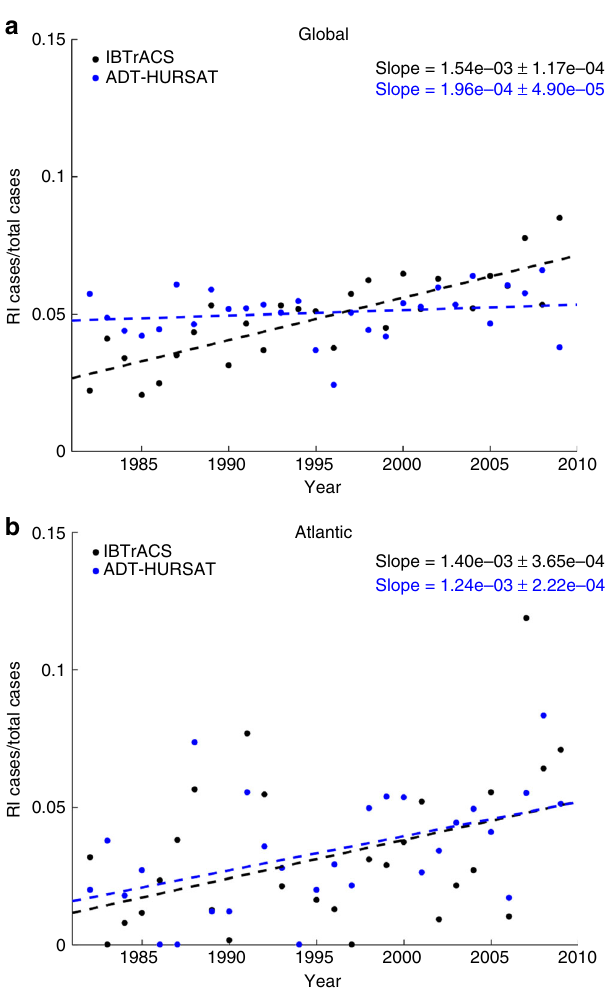
Fig. 4 The effects of quantile mapping on 24-intensity change probability densities. a , b Common logarithm of the probability densities calculated from IBTrACS (black), ADT-HURSAT (blue), HiFLOR 1990CTL (ORIG), HiFLOR QDM-corrected 1990CTL, and HiFLOR BCQM-corrected 1990CTL 24-h intensity changes. a Global and b Atlantic basin results are plotted. QDM and BCQM are quantile mapping designed to bias correct 1990CTL to more closely represent the distribution of IBTrACS. ADT-HURSAT and IBTrACS probabilities are computed using the 17-year period centered around 1990 (1982 – 1998). HiFLOR probability density curves are generated using 250 years of intensity changes from the 1990CTL. Data is binned in 20 knot increments between − 110 and 110 knots, and each bin entry is plotted as a dot on a curve. All distributions are bounded below by 10 − 5